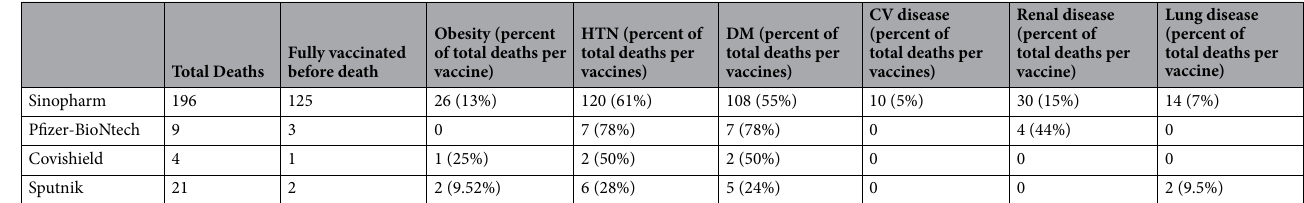
Table 5. Comorbidities present in vaccinated individuals who died from post-vaccination infections . Not all comorbidities were recorded, but the major comorbidities are represented in the chart. HTN hypertension, DM diabetes mellitus, CV cardiovascular disease (except HTN).